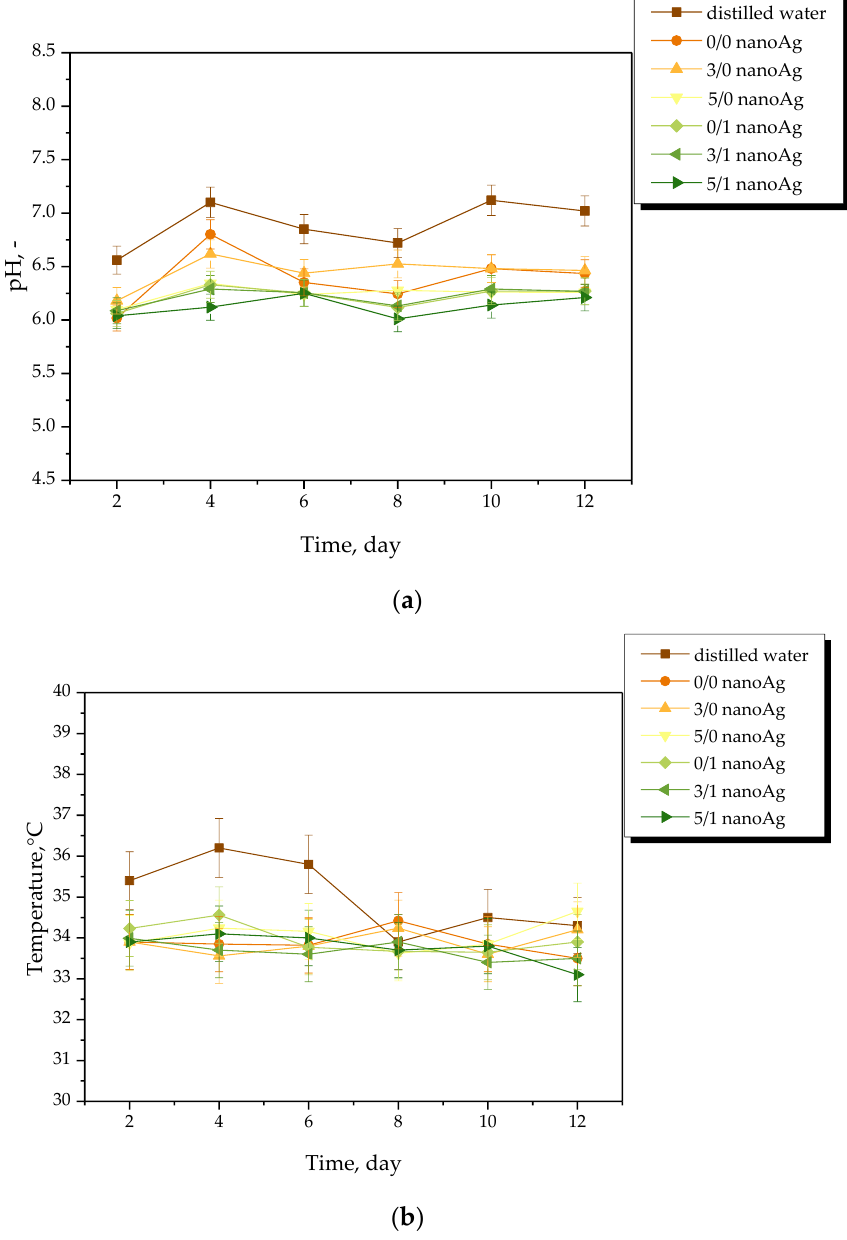
Figure 4. pH ( a ) and temperature ( b ) measurements of distilled water during hydrogels’ incubation (n = 3, n — number of repetitions).